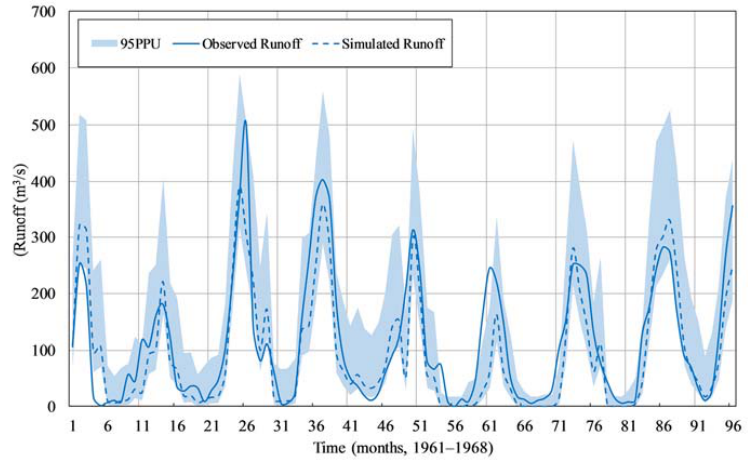
Figure 4. Monthly observed and simulated runoff at the Derbendekhan outlet and 95PPU for the period 1961–1968.